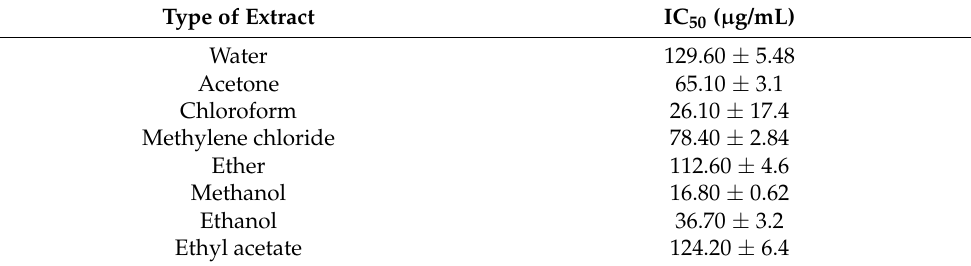
* Radical scavenging activity given as percentage inhibition. The percentage inhibition value of the standard compound ascorbic acid was 99.23% at a concentration of 1280 µ g/mL. Means followed by different letter (s) within a column or row are significantly different ( p ≤ 0.05) according to Duncan’s multiple range test. Table 2. IC 50 values of Solenostemma argel